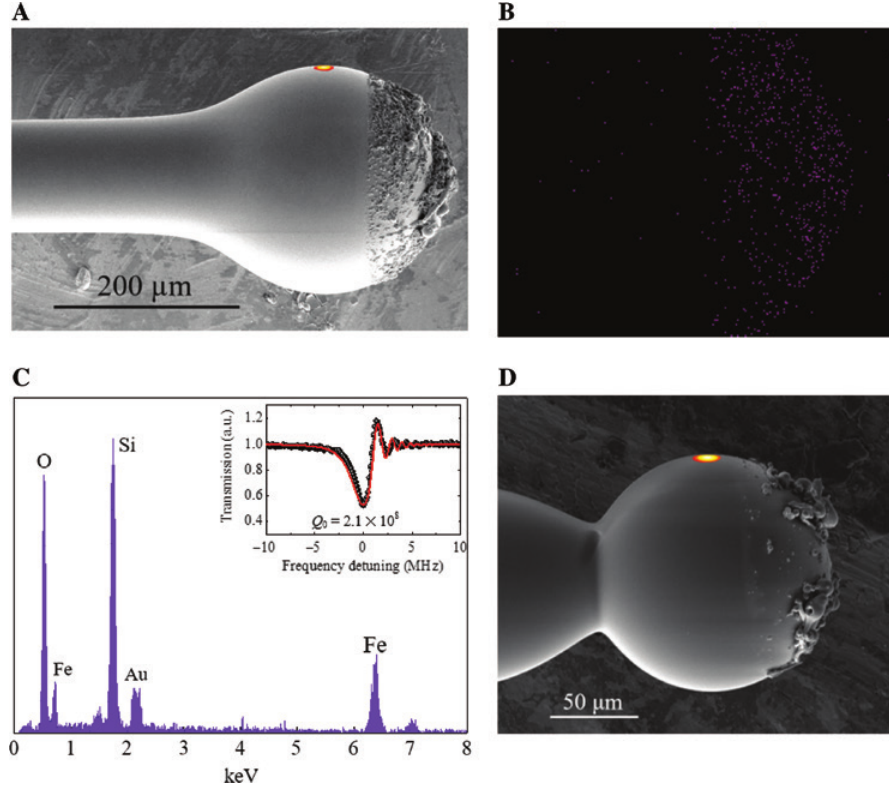
Figure 2: Characterization of the functionalized microsphere resonators. (A) Scanning electron microscopic (SEM) image of the functionalized silica microsphere resonator with a diameter of about 248 μ m. (B) Ferrum distribution on the end surface of the functionalized microsphere. (C) Measured energy dispersive X-ray spectrum of the coating area. The inset is the measured transmission spectrum. The red line is the theoretical fitting curve. (D) SEM image of the functionalized microsphere resonator with a diameter of about 139 μ